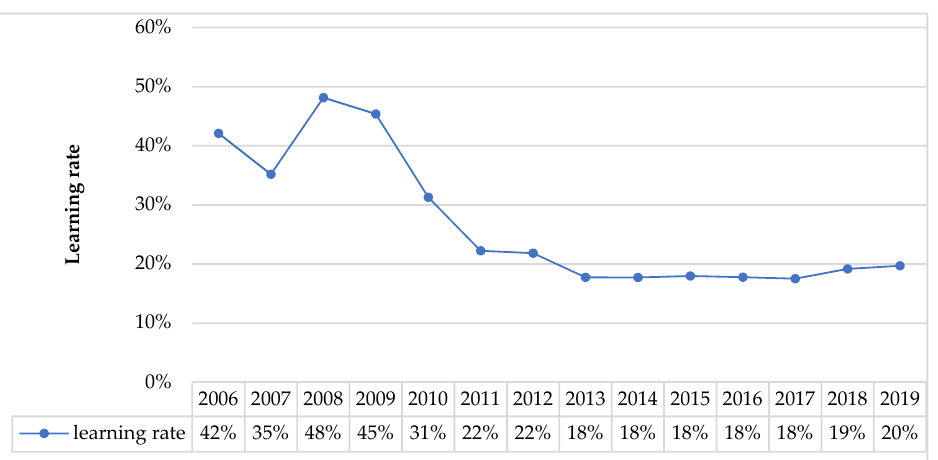
Figure 6. Learning rate (LR) Cost of CPV in China.